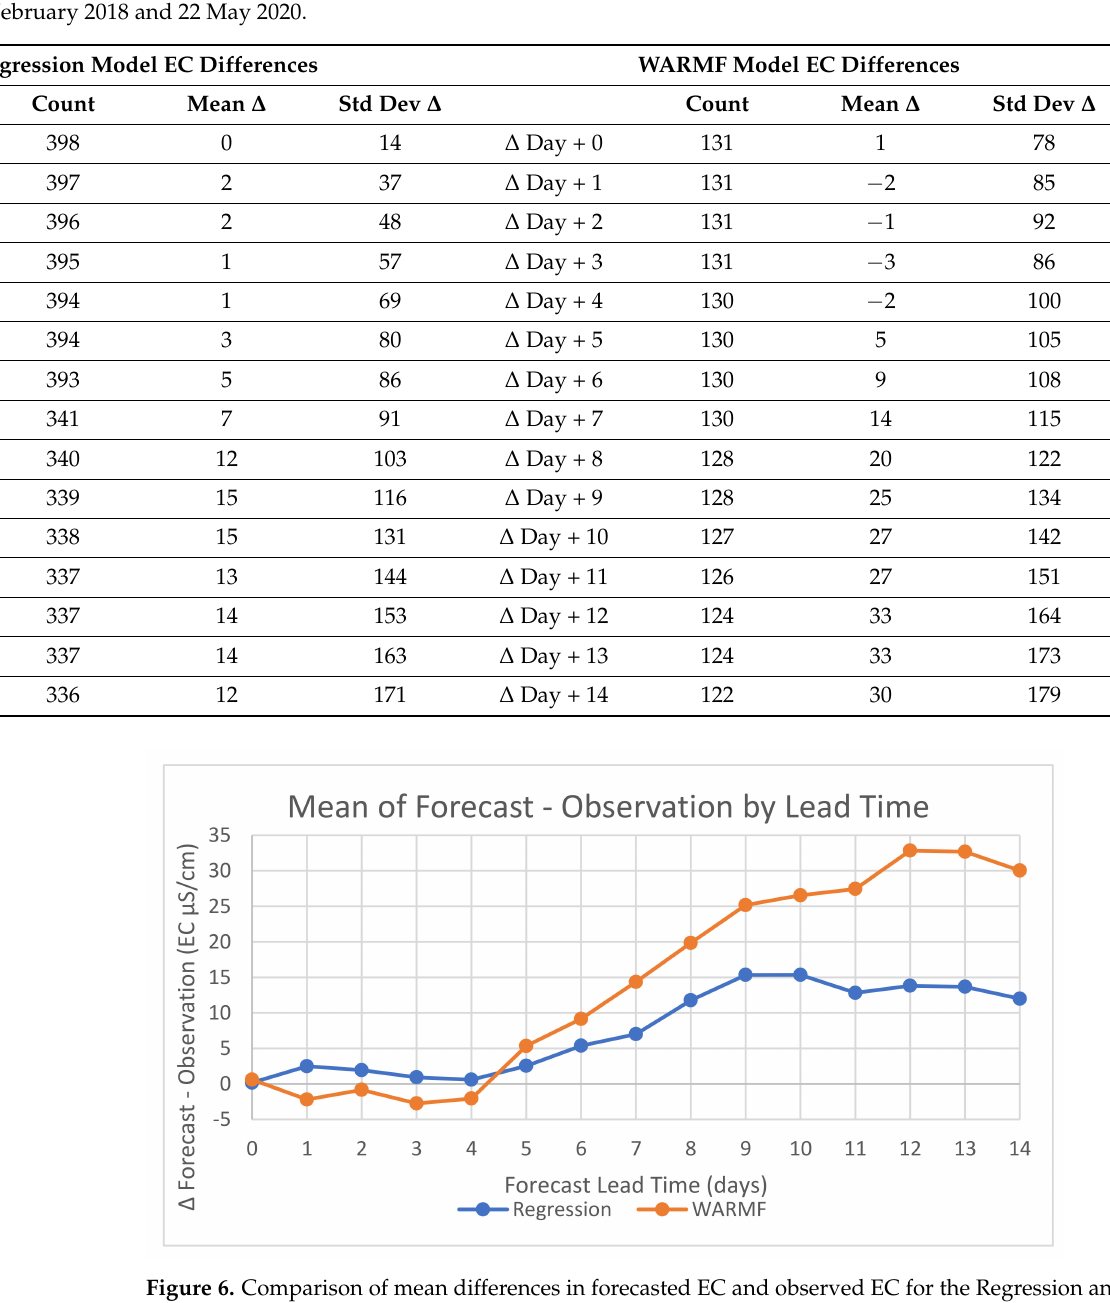
Figure 6. Comparison of mean differences in forecasted EC and observed EC for the Regression and WARMF models for the period between 22 February 2018 and 22 May